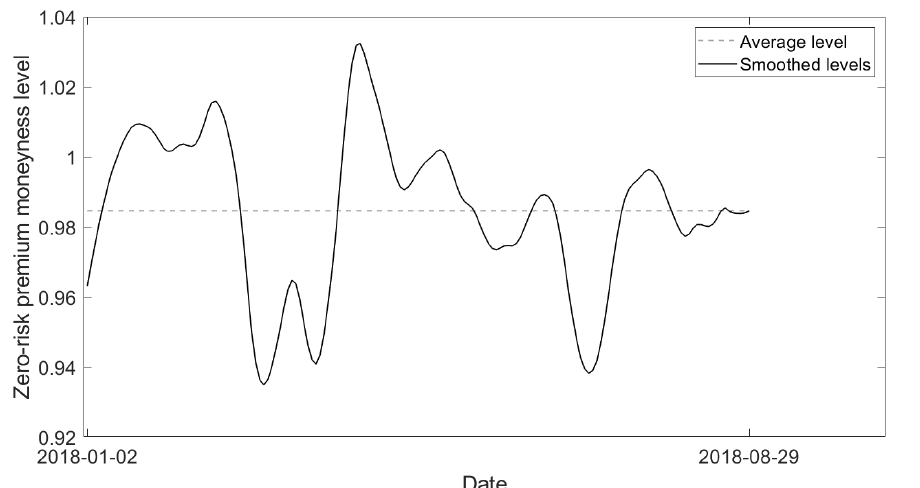
Figure 5. Evolution over time of the zero-risk premium strike of a European call option on the S&P500 index, with a fixed maturity of one month. The average moneyness level amounts around 98.5%.